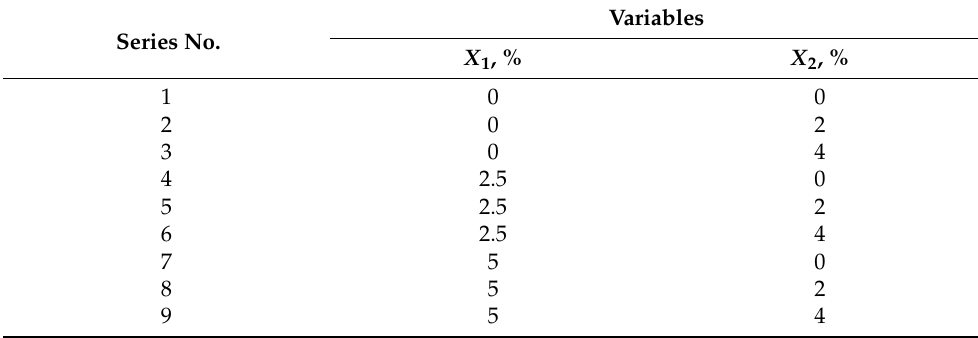
Table 8. Experimental plan.